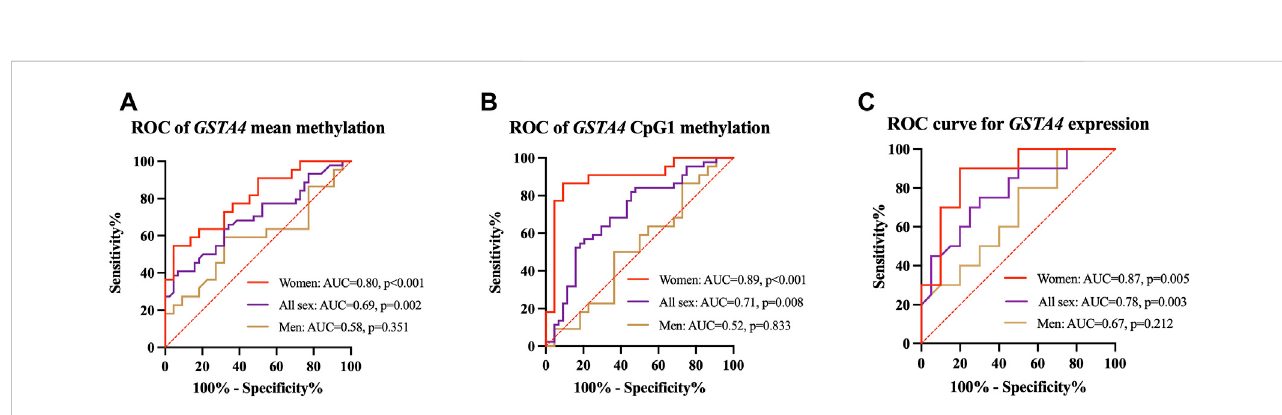
FIGURE 4 ROCcurves forpredictionofIAsinmenandwomen. (A) GSTA4 meanmethylationisapredictorofwomenIA. (B) GSTA4 CpG1methylationisapredictor of women IA. (C) GSTA4 expression is a predictor of women